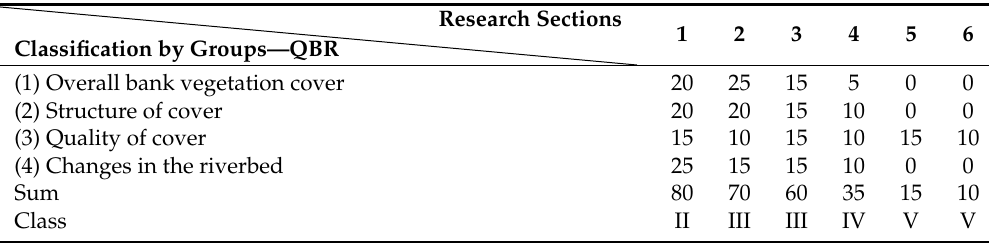
Table 9. Results of the hydromorphological status testing in the research sections under analysis based on the QBR